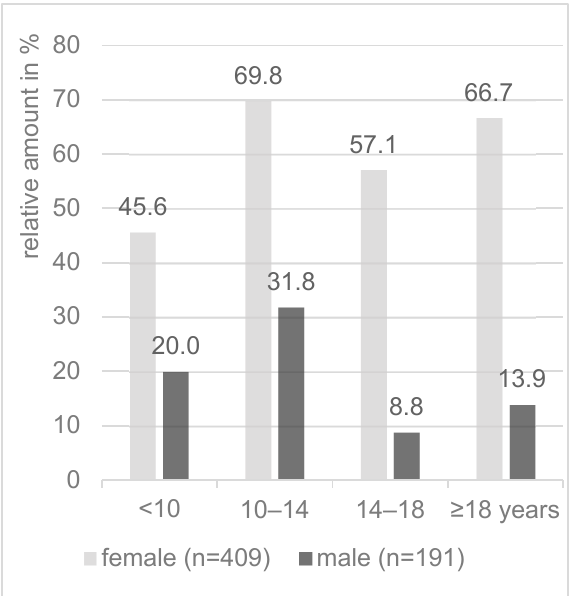
Figure 6. Low body weight by age group (ages < 10–17 years: <10th BMI percentile [26]; age ≥ 18 years: BMI <18.5 kg/m 2 [28]).